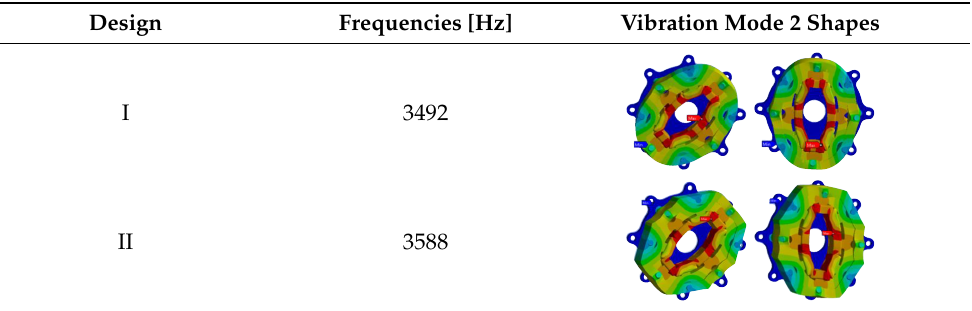
Table 13. Design I and II mode 2 natural frequencies.